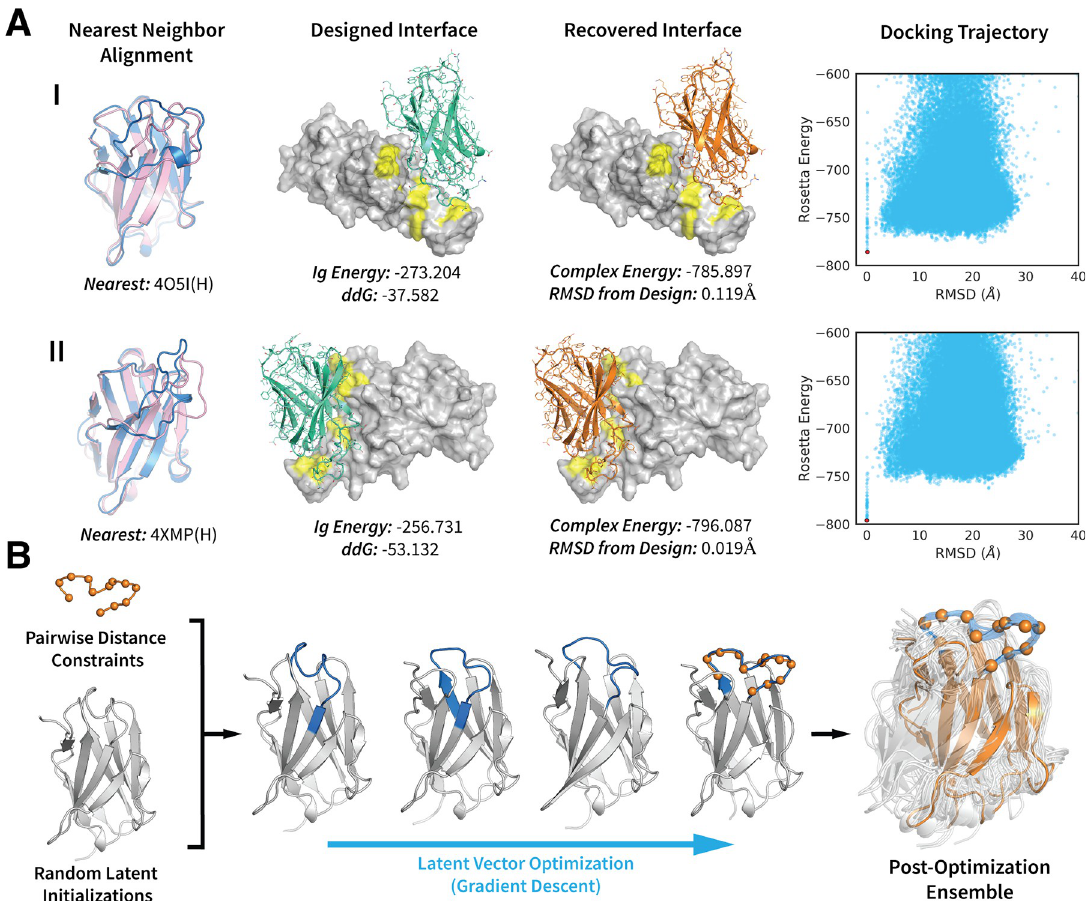
Fig 5. Towards Epitope-Specific Generative Design. (A) Design of two generated immunoglobulin (Ig) structures, I and II, targeting the ACE2 epitope of the SARS-CoV2 receptor binding domain (RBD). The left-most column shows an alignment of the unrefined generated structures (pink) to their respective nearest neighbors (blue) in the training set. The second column depicts the designed interfaces with the full-sequence Ig’s shown in green. The SARS-Cov2-RBD is rendered as a white surface, with the ACE2 epitope shown in yellow. The ddG’s and Rosetta energies (ref2015) of the Ig’s are shown below each complex. The third column depicts the lowest energy structures from a RosettaDock global-docking trajectory. The recovered Ig structures are shown in orange. The right-most column shows the full docking trajectory (100,000 decoys), with the lowest energy structures shown as red dots. (B) Ig-backbone design by constrained latent vector optimization. The loop constraints are taken from PDB:5X2O(L, 32–44) with the target shape shown by orange spheres. The constrained regions of the optimization trajectory are shown in blue. In the post-optimization ensemble the full 5X2O(L) backbone is shown in orange. The ensemble depicts the outputs of 62 optimization trajectories (out of 100 initialized) that successfully recovered the target loop